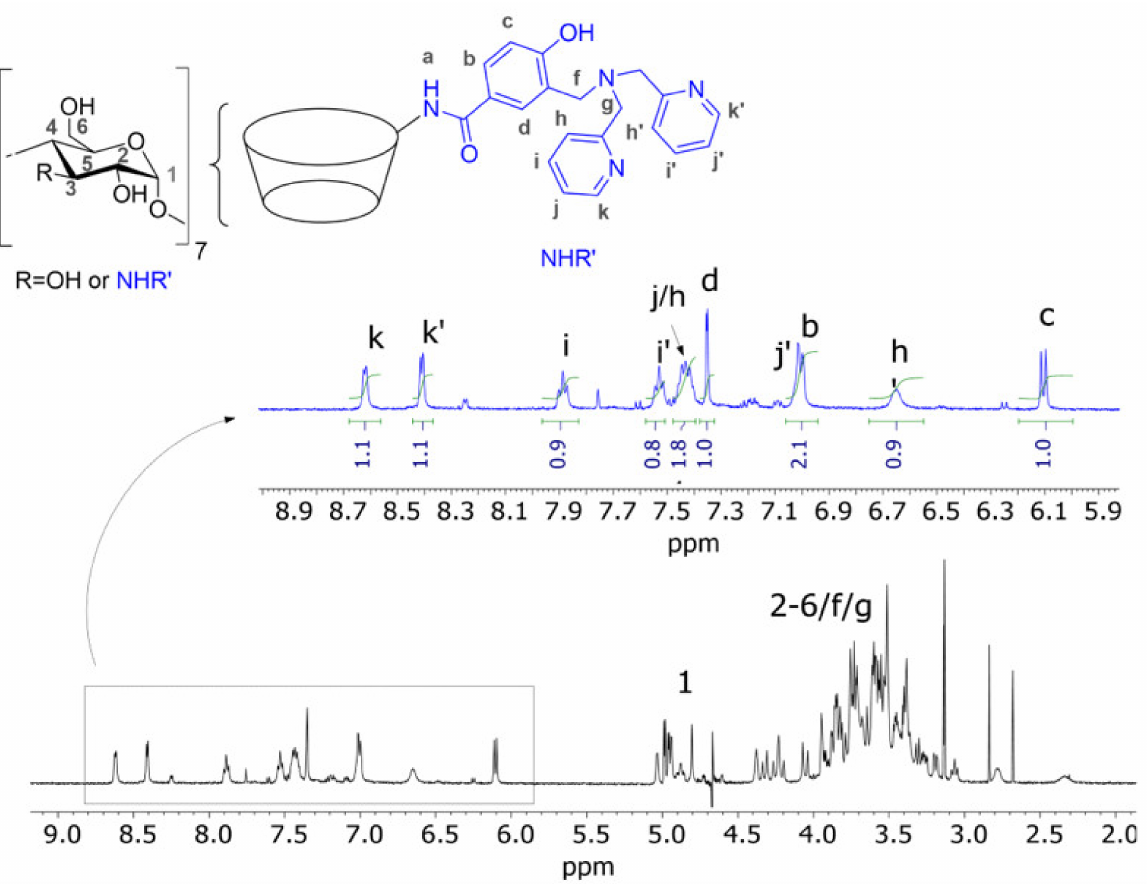
Figure 2. The 1 H NMR (500 MHz, 25 ◦ C, D 2 O) spectrum of dpa- p -HB- β